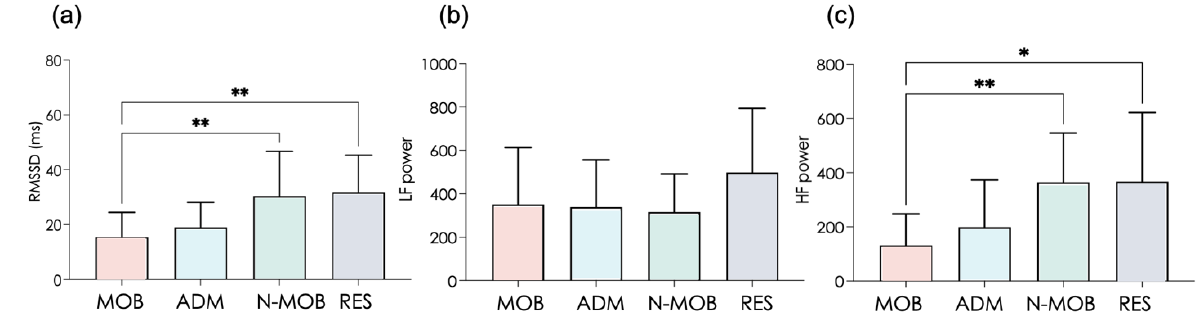
Figure 3. Time and frequency domains markers extracted from RR intervals time series. ( a ) Root Mean Square of the Successive Differences, RMSSD; ( b ) power in low frequencies, LF power; ( c ) power in high frequencies, HF power. Error bars represent the standard deviation. * p < 0.05; ** p < 0.01.